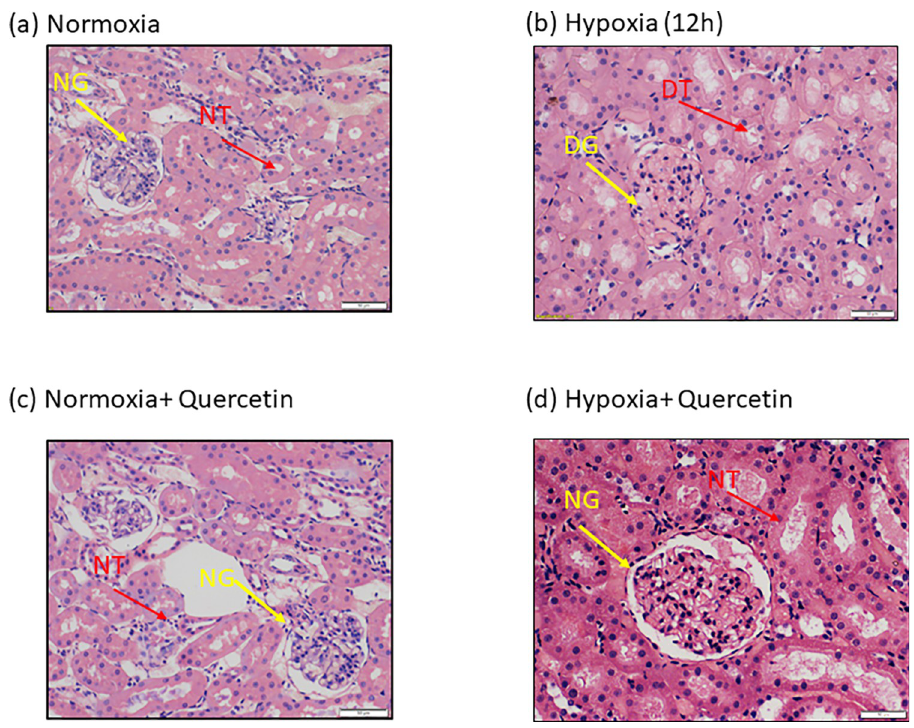
Fig 12. (a-d) Renal pictomicrographs images depicting the degeneration of renal tubules, glomerulus and Bowman’s capsule, swelling of renal tubules in rats exposed to hypobaric hypoxia at 7,620m, 25 ± 2˚C for 12h. (a) Photomicrograph (20X) section of kidney from Normoxia control group representing intact normal glomerulus (NG) and Bowman’s capsule with normal tubules (NT) configuration (b) Kidney sections (20X) of hypobaric hypoxia exposed animals for 12h duration had demonstrated the excessive degeneration of glomerulus with loss in integrity of Bowman’s capsule (EDG), Excessive ballooning of tubular cells, along with swelling of renal tubules (EDT) and mesangial proliferation. These animals (12h) also showed large spaces in between the Bowman’s capsular glomeruli and congestion of vessels (c) Photomicrograph (20X) sections of kidney from normoxia animals receiving Quercetin showed no noticeable changes as compared to normoxia control and (d) whereas rats exposed to hypobaric hypoxia (12h) and supplemented with Quercetin showed no structural changes in glomerulus and Bowman’s capsule along with clear tubular structures. EDG: Excessive degeneration of glomerulus and Bowman’s capsule, EDT: Excessive degeneration and swelling in renal tubules. NG : Normal intact glomerulus and Bowman’s capsule, NT : Normal renal